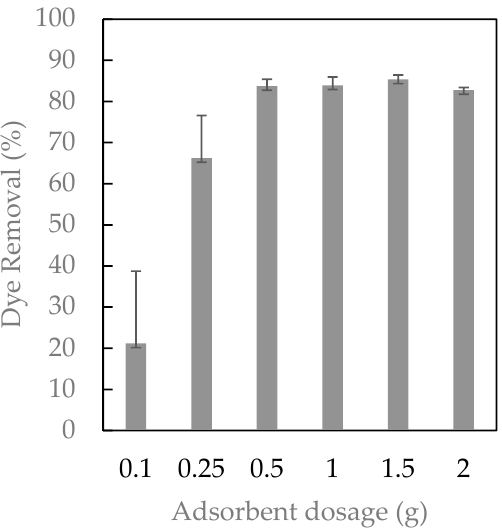
Figure 7. The effect of adsorbent dosage on the removal of Direct Red 83:1.